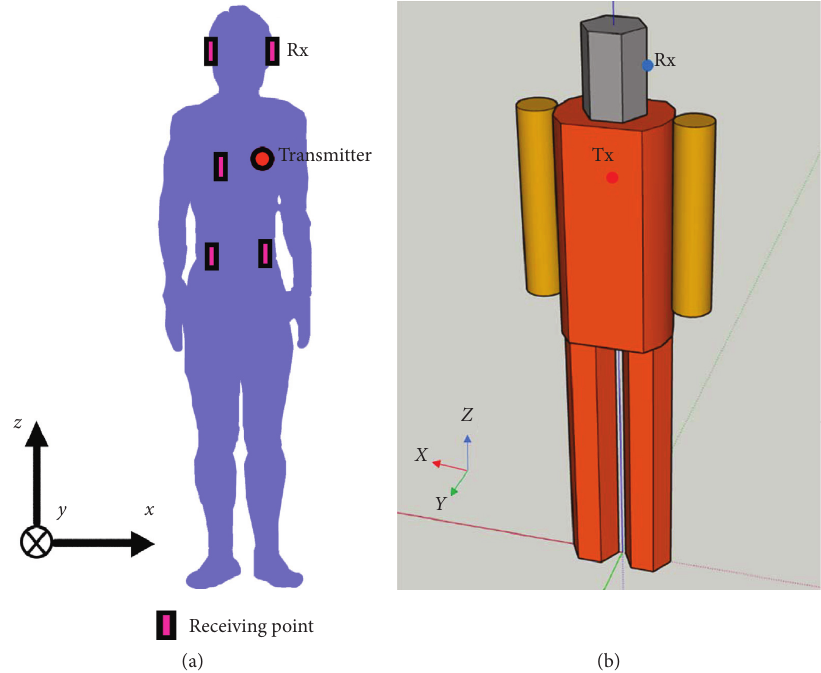
Figure 9: Positions of the Tx and Rx. (a) Measurement [23]. (b) Simulation with human body model 3 in Table